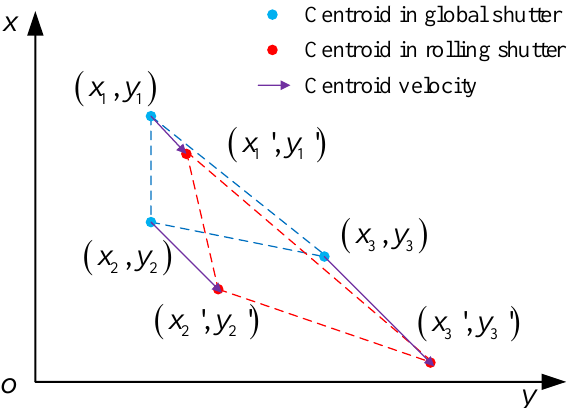
Figure 5. Schematic diagram of centroid error of in rolling shutter exposure.